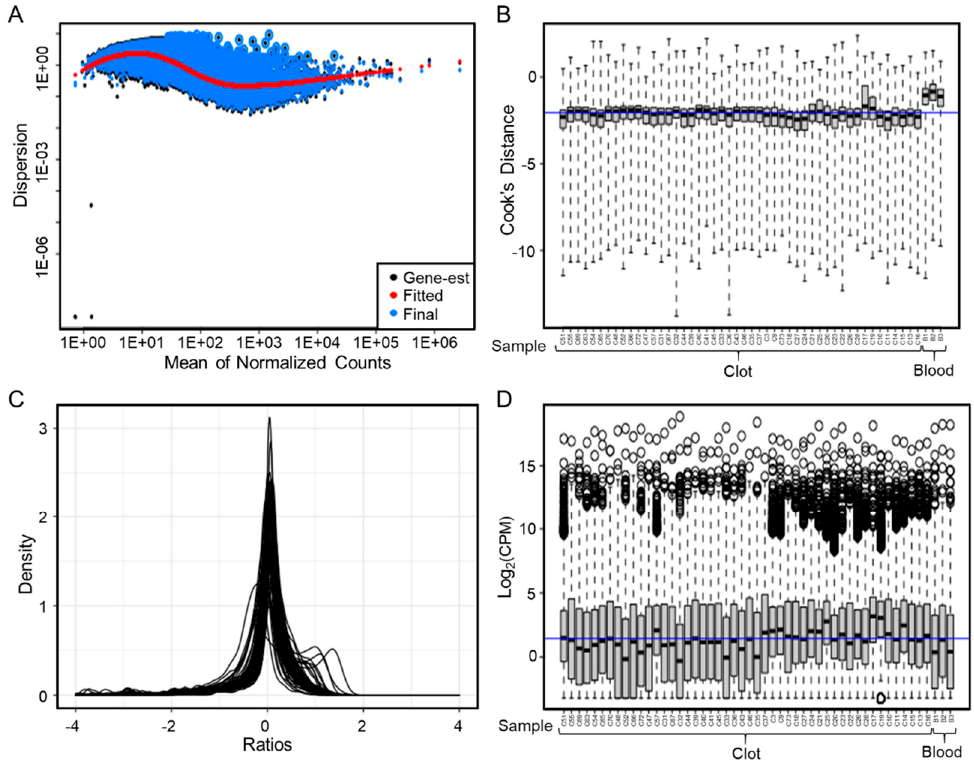
Figure 2. RNA Sequencing QC Analysis. ( A ) A dispersion plot in DESeq2 showing variation in the expression data. ( B ) A plot of Cook’s Distance in DESeq2 for each sample. ( C ) The distribution of the ratios in almost all cases was normal. ( D ) Boxplots of log-transformed CPM expression show no outlier samples. (Abbreviations: CPM = counts per million).